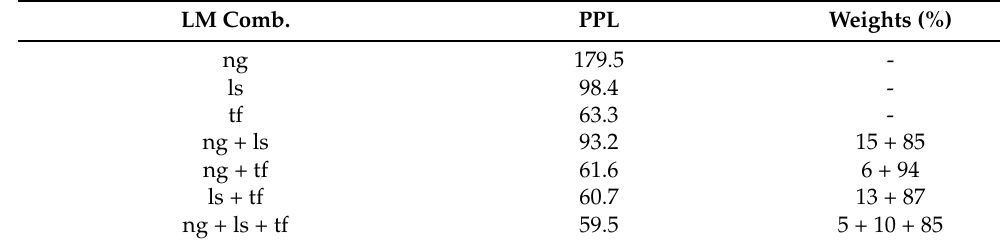
Table 4. Perplexity (PPL) and interpolation weights, computed over the dev1-dev set, of all possible linear combinations of n-gram (ng), LSTM (ls) and Transformer (tf) LMs. LM